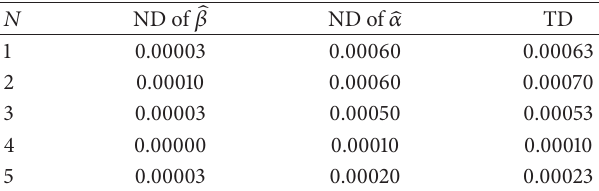
Table 2: Deviation of the parameter